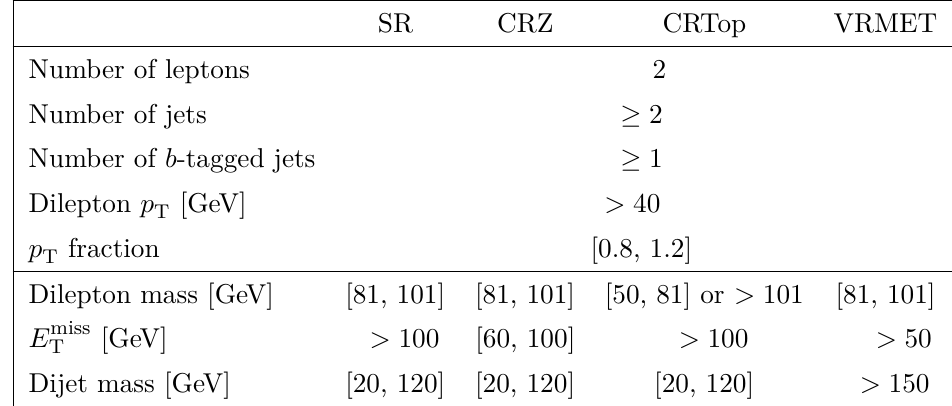
Table 2. Summary of the event selection criteria for the signal region (SR), Z +jets control region (CRZ), tt control region (CRTop), and a validation region for E miss (VRMET). The first five selection criteria are common to all